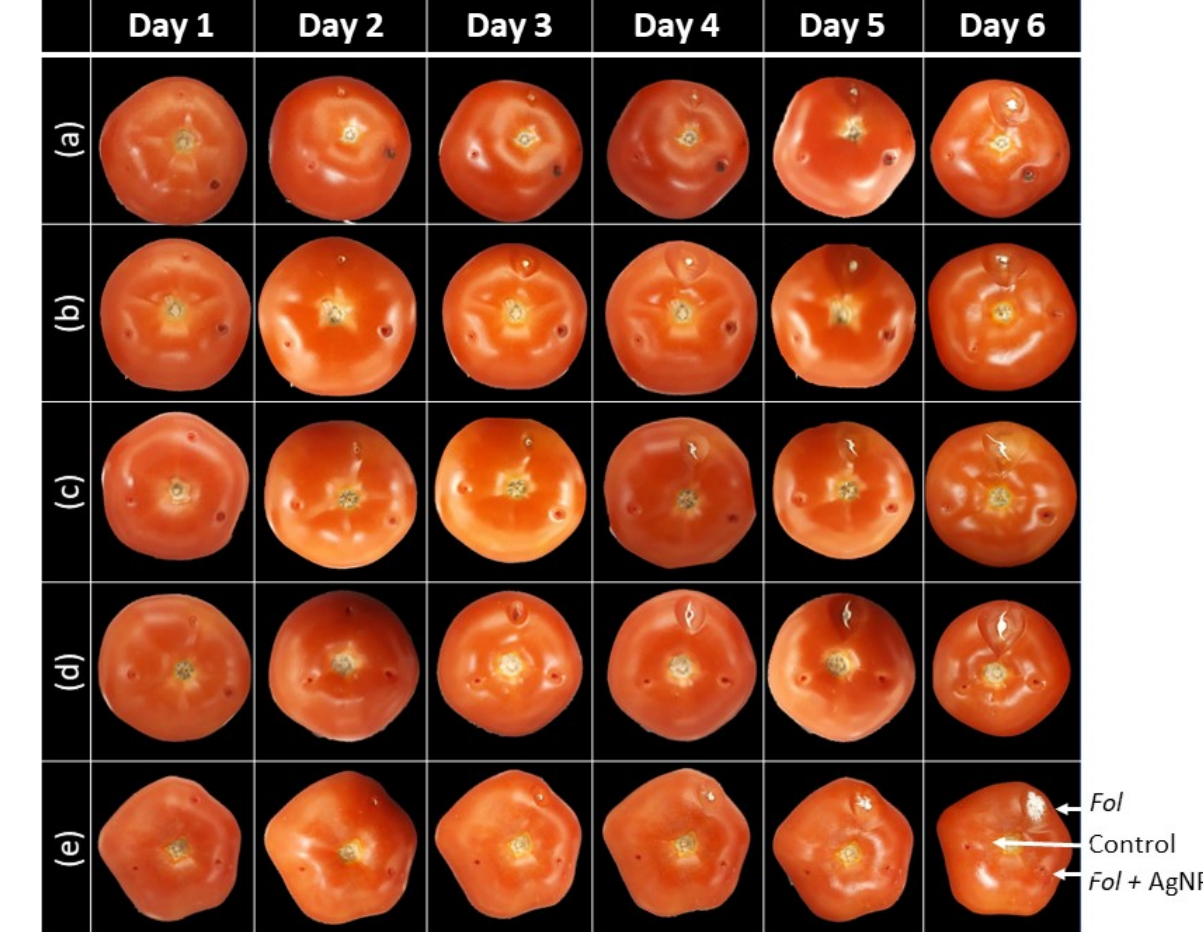
Figure 4. Test of antifungal activity of AgNPs, synthetized by the green route, at different concentrations, in tomatoes. Arrows indicate how each tomato was inoculated: 1.5 × 10 5 Fol spores ( up ), distilled water as the control ( left ), and 1.5 × 10 5 Fol spores with AgNPs at a concentration of ( a ) 150 mg/L, ( b ) 75 mg/L, ( c ) 40 mg/L, ( d ) 20 mg/L, and ( e ) 10 mg/L.